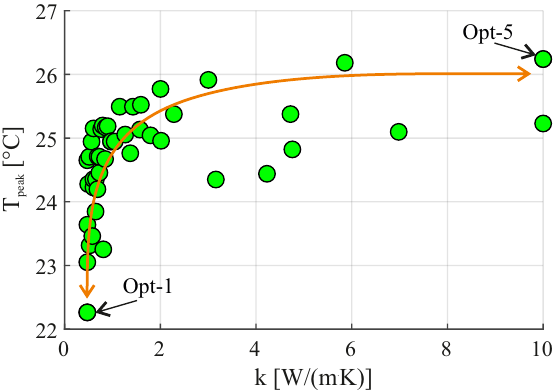
Figure 8. Relationship between optimal design variables for Case